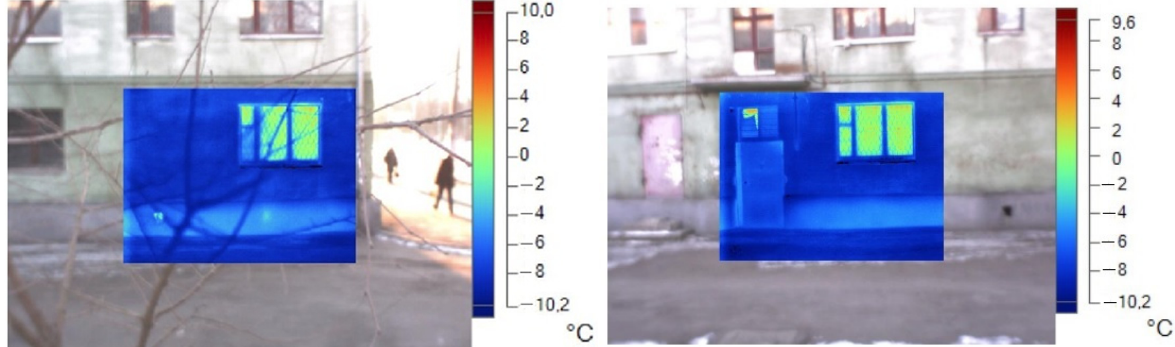
Figure 3. Thermal images of the external side of the building.